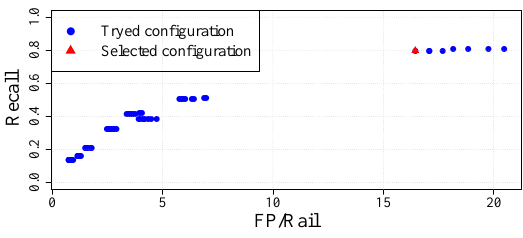
Figure 12. Evaluated configurations for mask